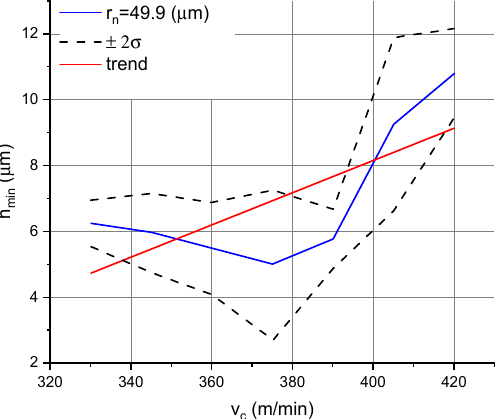
Figure 5. Minimum chip thickness vs. feed for the DCMT 11 T3 08–PF 4325 insert with a 49.9 µm edge radius.